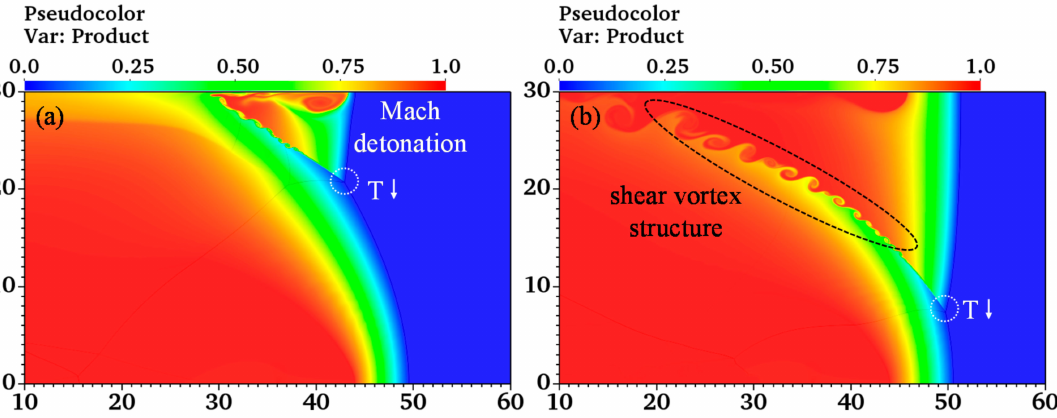
Figure 4. Contour of reaction progress variable after single-jet initiation: ( a ) t = 195 µ s; ( b ) t = 220 µ s.